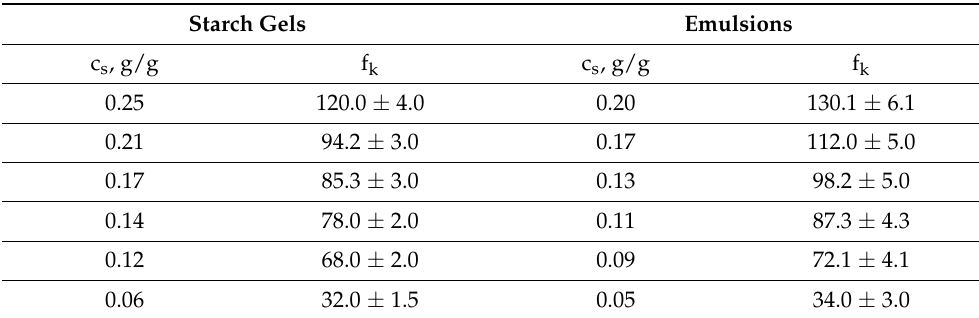
Table 1. The dependence of final f k functionalities on the starch concentration in the starch gels and emulsions. The values are expressed as means ± SD ( n = 3).